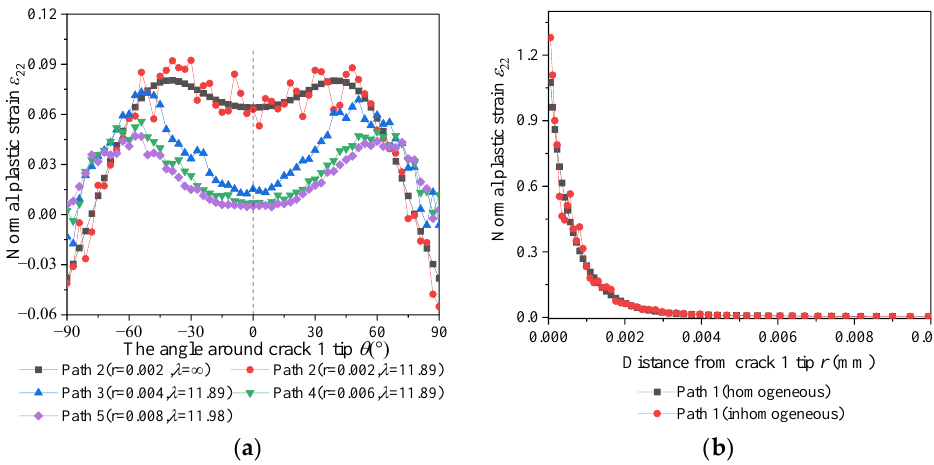
Figure 10. Normal plastic strain under homogeneous and inhomogeneous conditions: ( a ) around the crack 1 tip; ( b ) in front of the crack 1 tip.